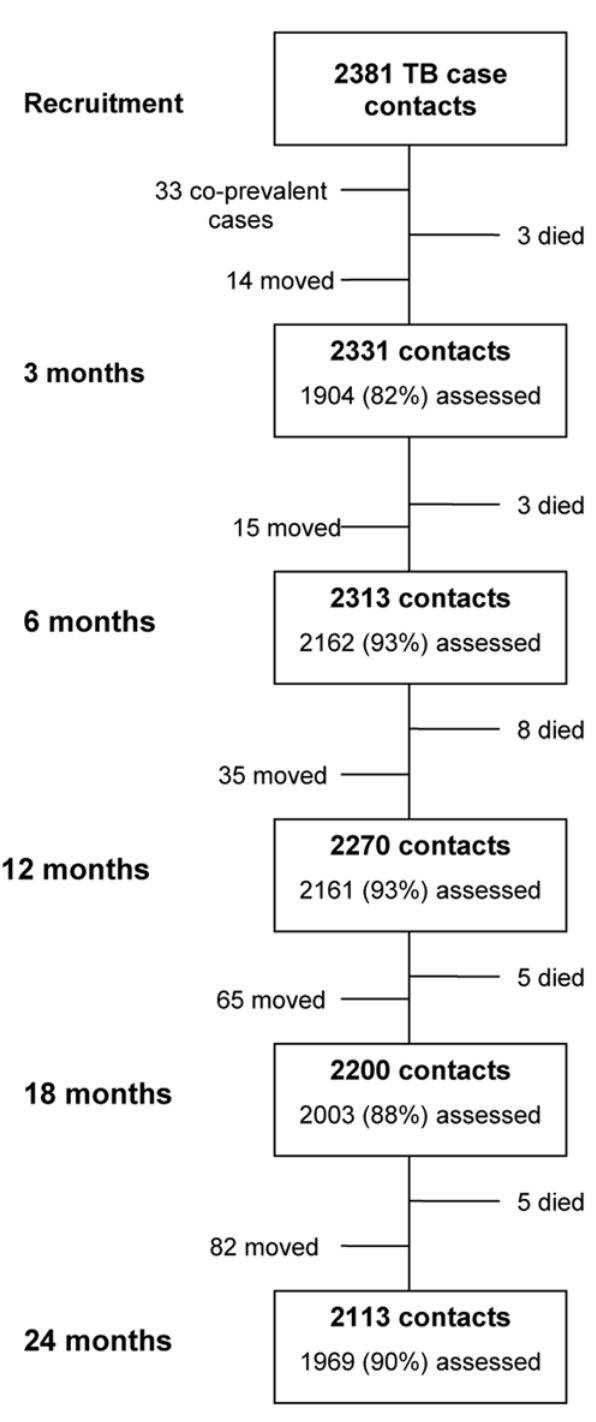
Figure 1. Study profile.